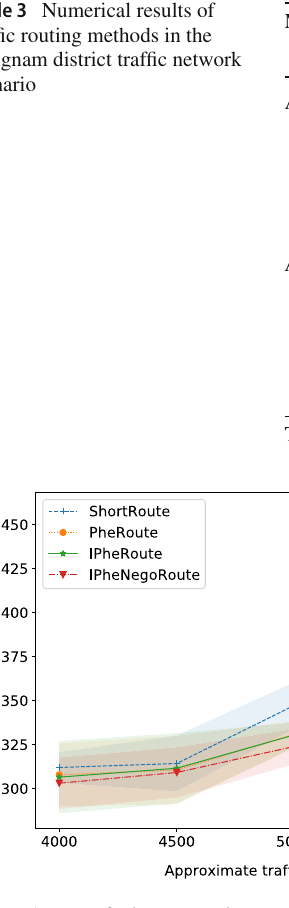
In the IPheNegoRoute method, it is assumed that all vehicles are altruistic agents which prioritize minimizing the global cost or average travel times of vehicles.